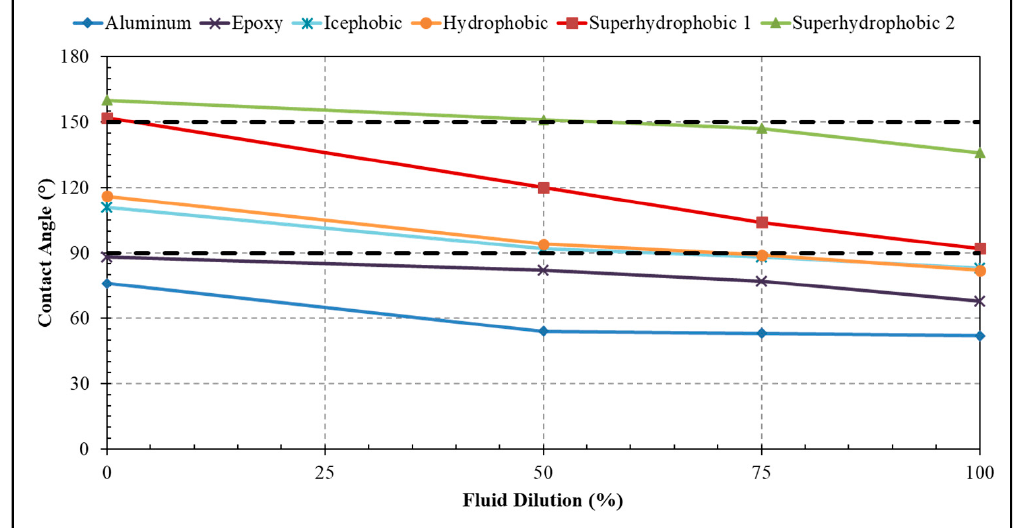
Figure 5. Contact angle of Ref. Fluid with each set of surfaces as a function of its dilution (% V / V ).